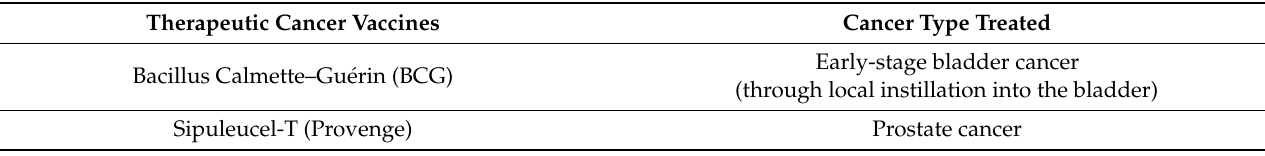
Table 2. List of FDA-approved therapeutic cancer vaccines.